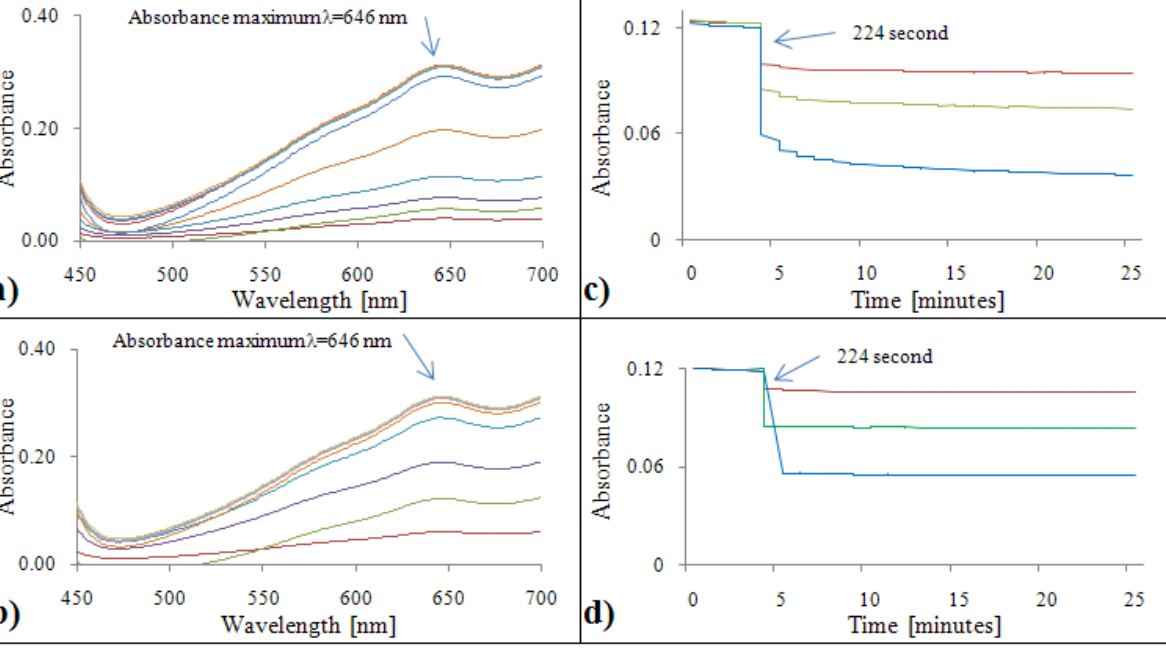
Figure 2. ABTS absorption spectra (450 – 700 nm) for gallic acid (a) and Trolox ® (b) . Dependence of absorbance of ABTS radical with gallic acid (c) and Trolox ® (d) on